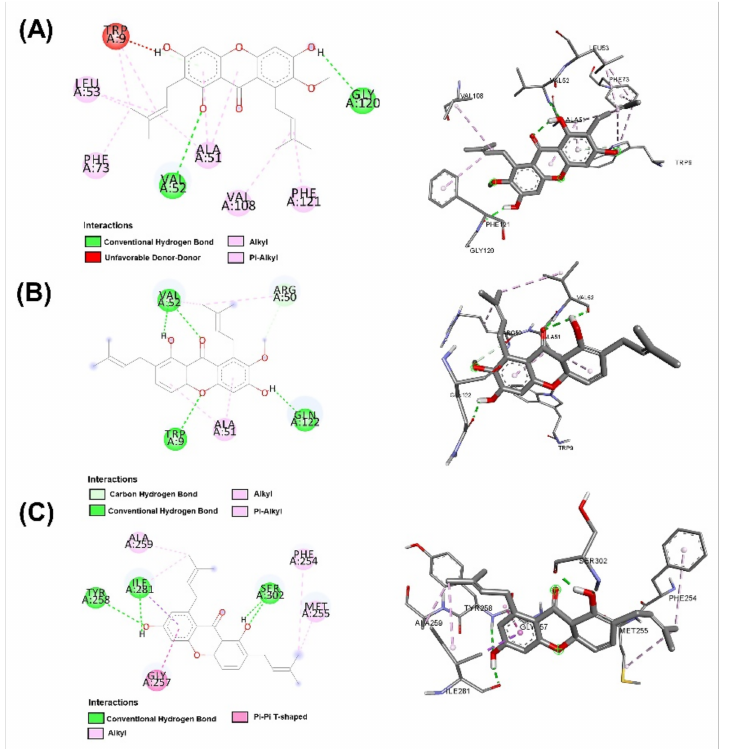
Figure 3. Post docking analysis visualized by Discovery Studio visualizer in 2D and 3D poses in beta-tubulin with ( A ) alpha-mangostin, ( B ) 1,6-dihydroxy-7-methoxy-2,8-bis(3-methylbut-2-en-1-yl)- 9H-xanthen-9-one, and ( C )